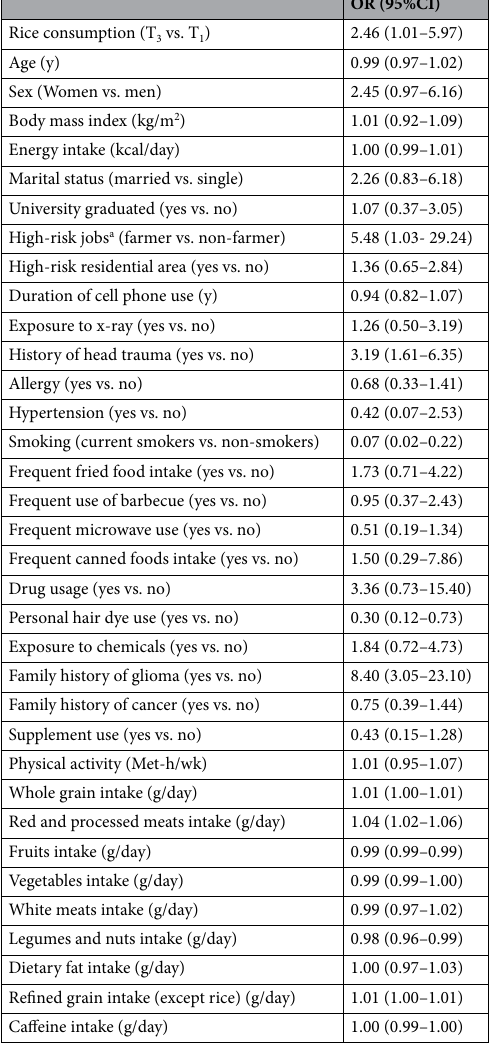
Table 4. Multivariable-adjusted odds ratios and 95% CIs for glioma across all studied variables. a Adjusted for all other variables in the